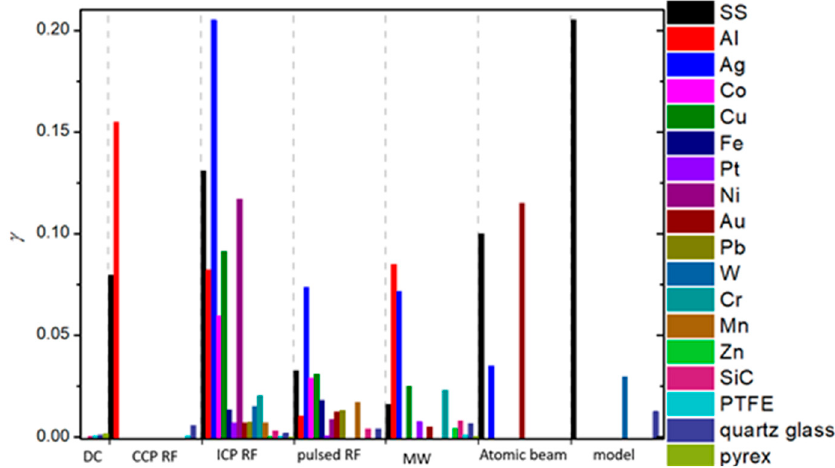
Figure 6. Comparison of average values of γ determined using different experimental and theoretical approaches. Table 1. Advantages and disadvantages of various types of gaseous discharges.